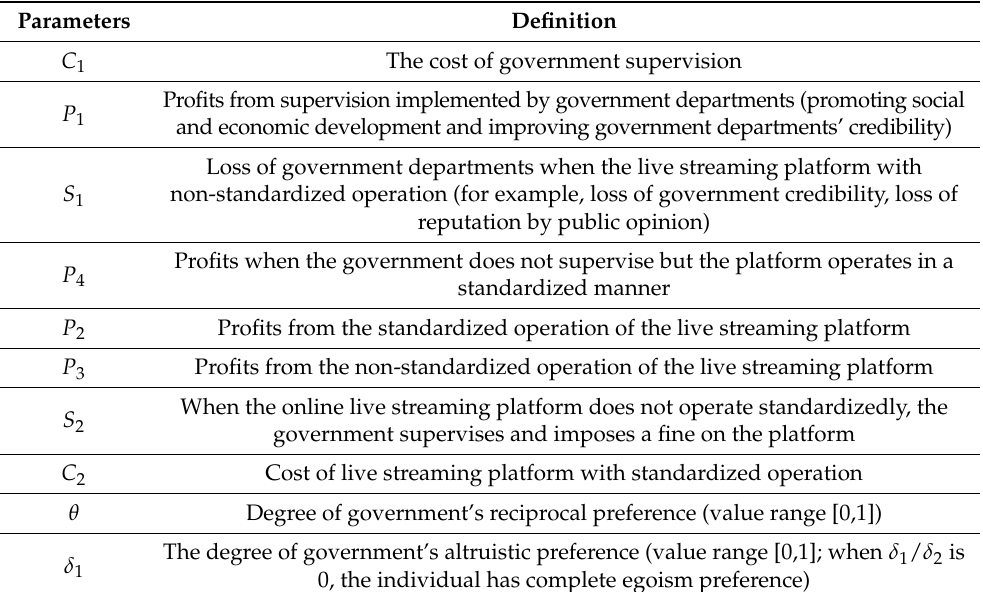
Table 7. The definition of parameters involved in the game between the government and the live streaming